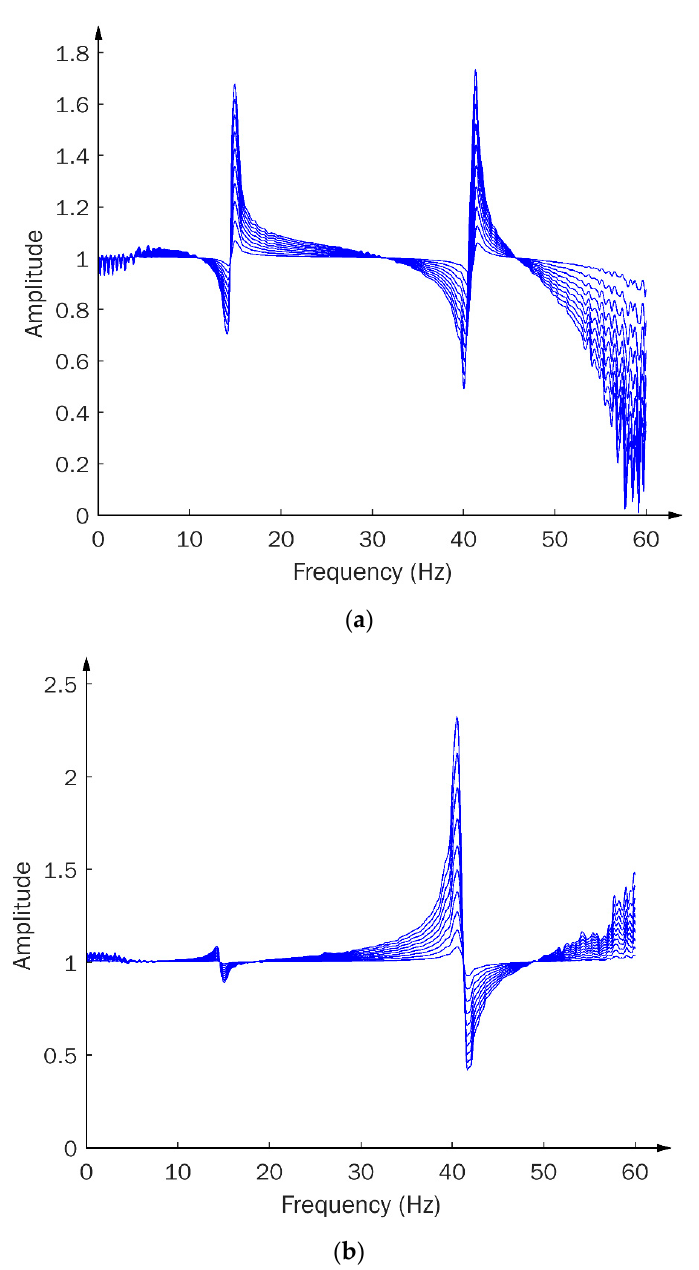
Figure 7. TFs between accelerations b and a under ( a ) stiffness loss of brace A, ranging from 5% to 50% at 5% intervals; ( b ) stiffness loss of brace B, ranging from 5% to 50% at 5% intervals.